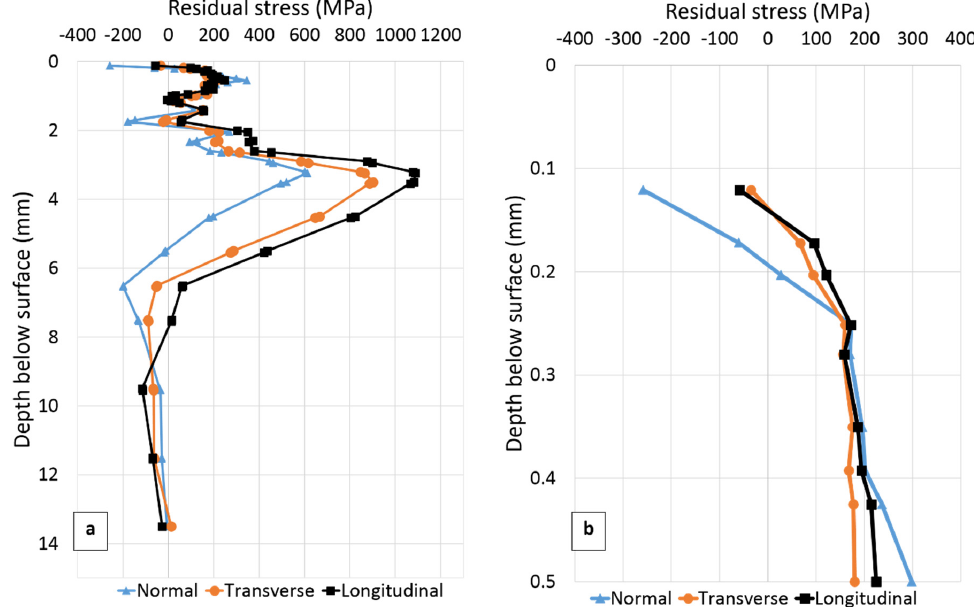
Figure 6. ( a ) Residual stresses as function of distance below the plate surface at the weld toe on the second welded side (SS-WT in Figure 4); ( b ) Residual stress from surface to 0.5 mm below the surface. Note the compressive residual stresses near the